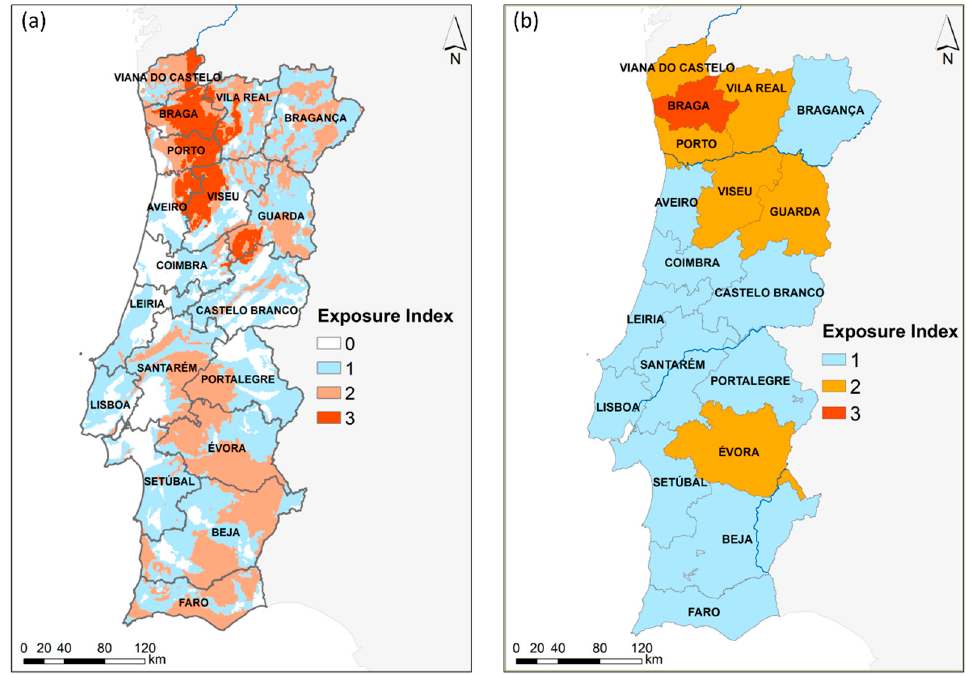
Figure 5. ( a ) Bioclimatic-shift exposure index (BSEI) for mainland Portugal and ( b ) related areal mean values for each district (note: BSEI attained between 1990–2019 and 1950–1979).